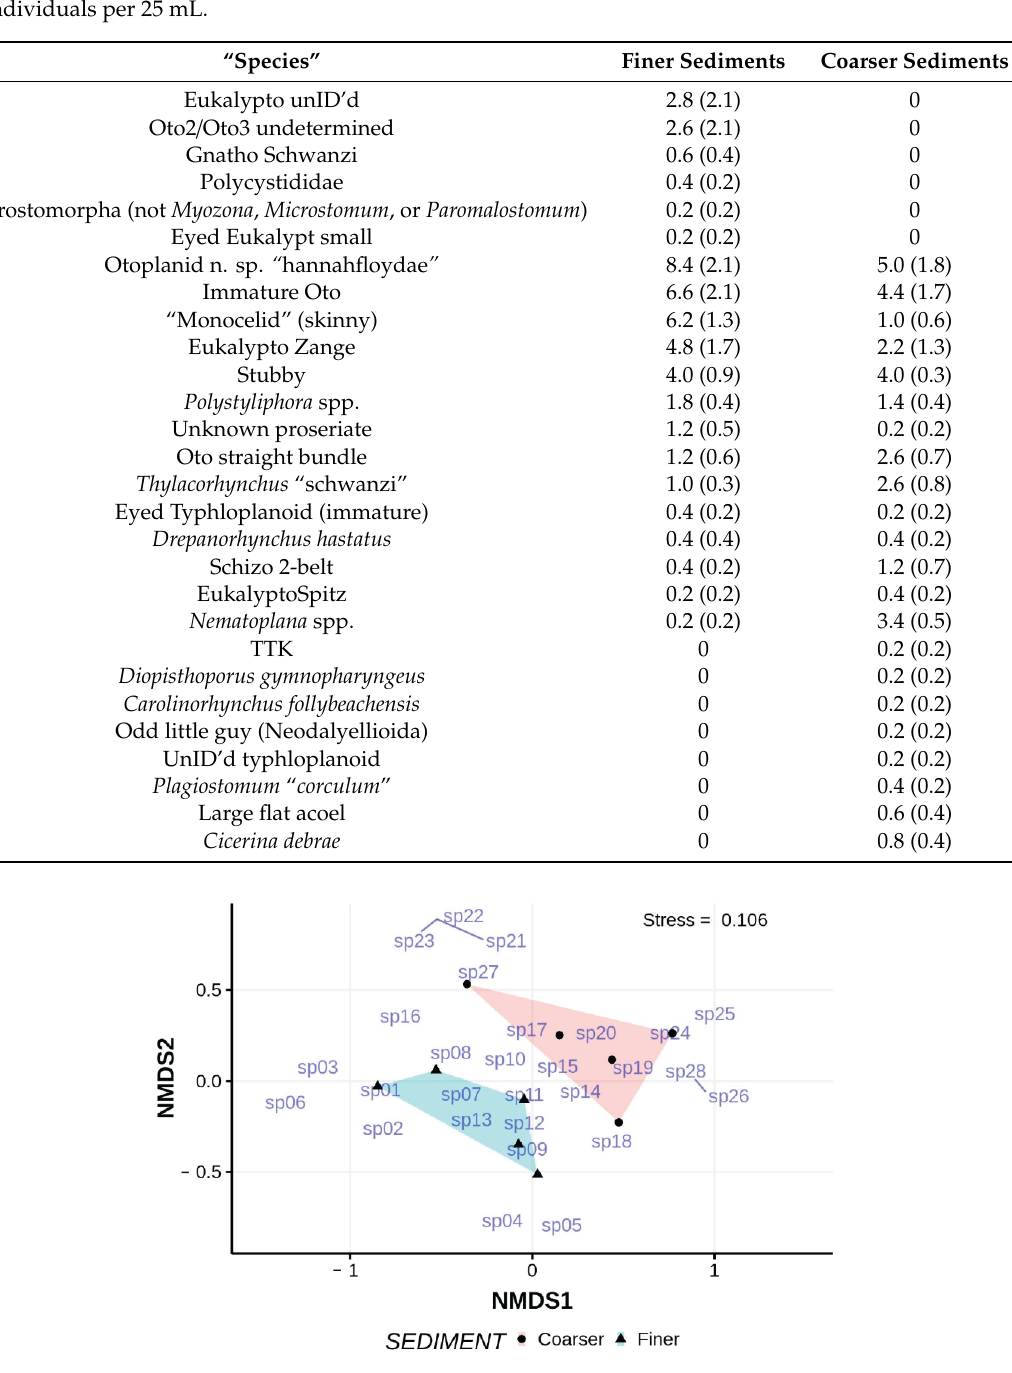
Figure 13. nMDS ordination of the abundances of turbellarian species found in finer and coarser sediments collected from the lower intertidal of EI beach in 2012; non-metric scales serve to ease visual estimation of dissimilarity distances but are not associated with any specific units. Species codes, "sp__", reference to the sequence of species listed in Table 7. Names of undescribed taxa used here are labels and not being made available for formal taxonomic purposes.